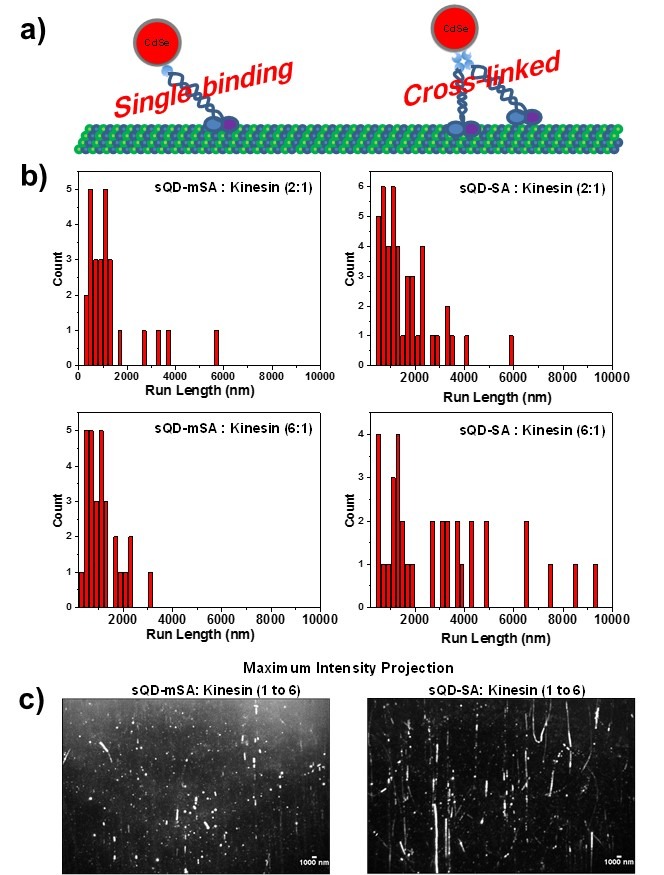
Measurement the run-length of kinesin using mSA-small qdot and SA-small qdot.(a) schematics to show the possibility of crosslinking multiple kinesin on qdots. Since a mSA is monovalent, there is no possibility to bind multiple kinesin. By contrary, a streptavidin has four binding sites for biotin, so that, even though each small qdot has only one streptavidin, SA-small qdots can bind more than one kinesin. (b) the measurement of the run length of kinesin at two different concentration ratio between qdots and kinesin. (c) kymograph for kinesin walking traces with 1:6 (small qdot: kinesin) ratio.